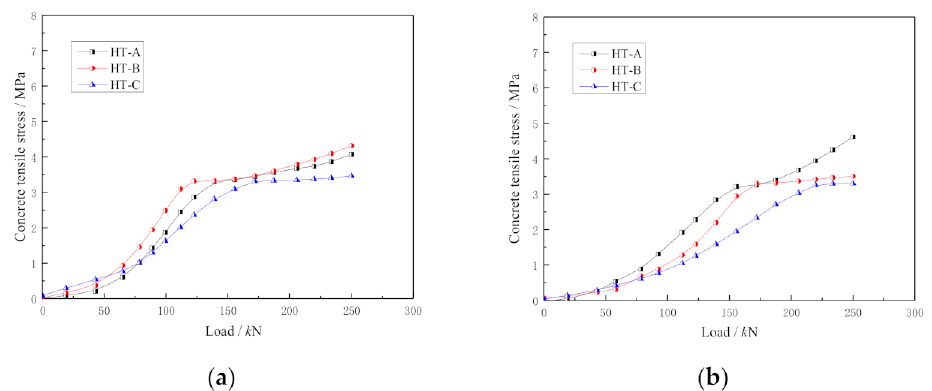
Figure 20. Concrete stress curve of GD-3 specimen: ( a ) No. 1 measuring point t and ( b ) No. 2 measuring point.